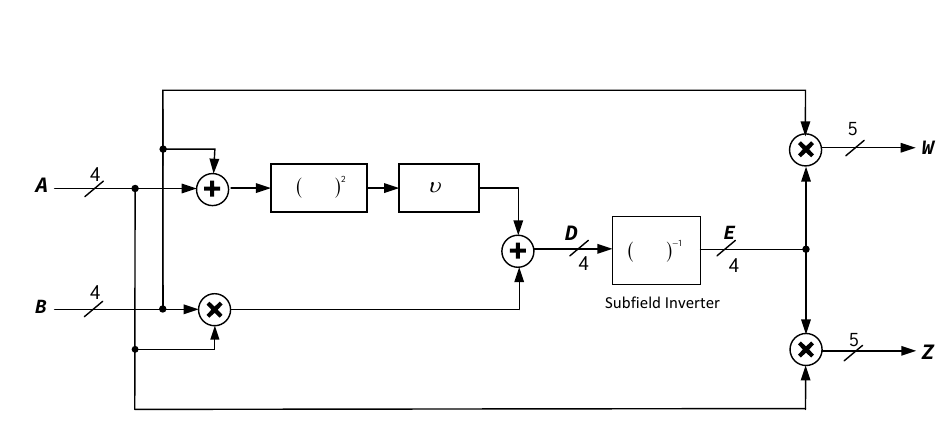
(cid:0) (cid:1) (2 4 ) 2 inversion using the NB representation at the